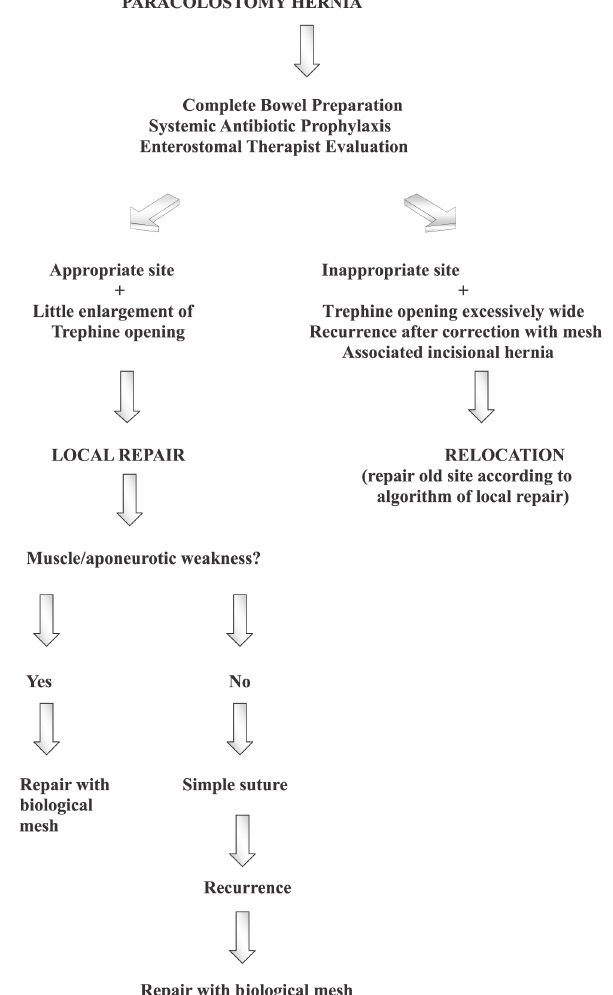
Figure 1 – Surgical management of paracolostomy